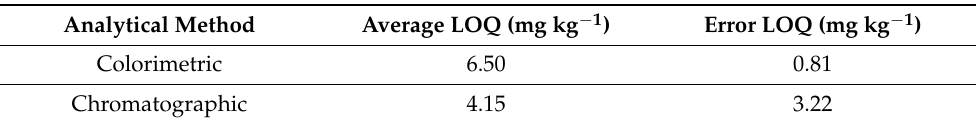
Table 2. Limits of quantification for the colorimetric and chromatographic methods of BS EN ISO